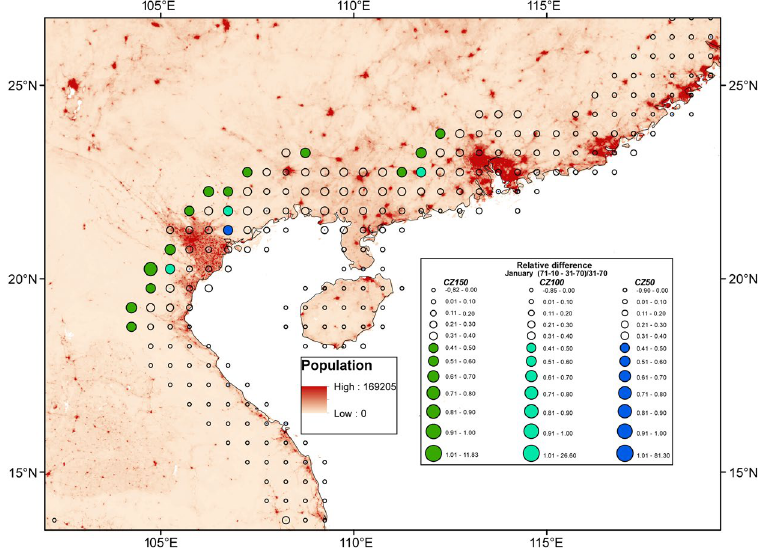
Figure 7. Regional example: Differences in January GPCC V2018 gridded precipitation means between 1971–2010 and 1931–1970 relative to the 1931–1970 period for the coastal zone of southern China. Circles indicate the magnitude of relative differences, with the smallest circles indicating negative differences and color indicating differences greater than 40% (see legend). A population density map is included, where the darker shades of red indicate higher densities. Maps were produced using Desktop ArcMap version 10.5.1 (https://